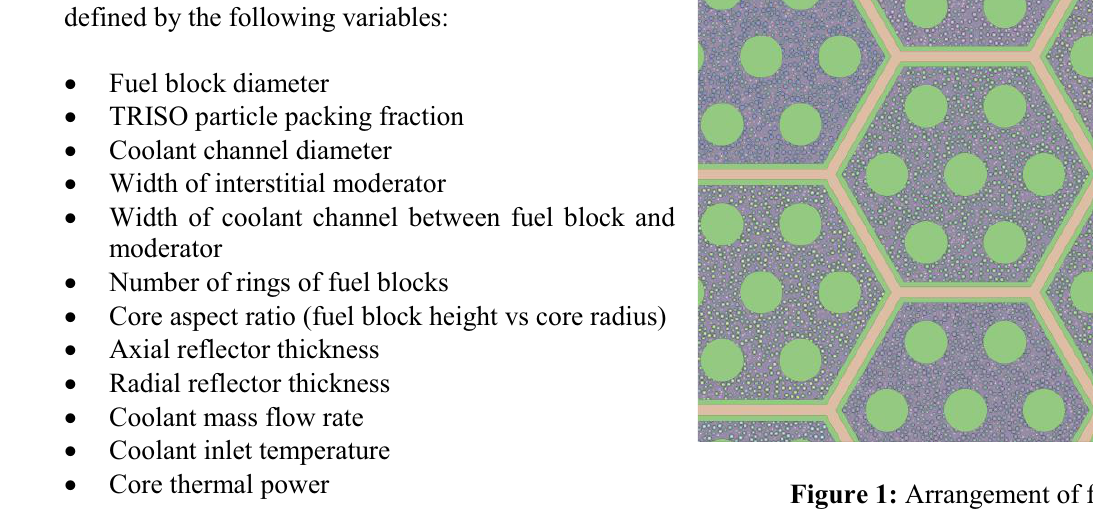
Figure 1: Arrangement of fuel, moderator (brown) and coolant